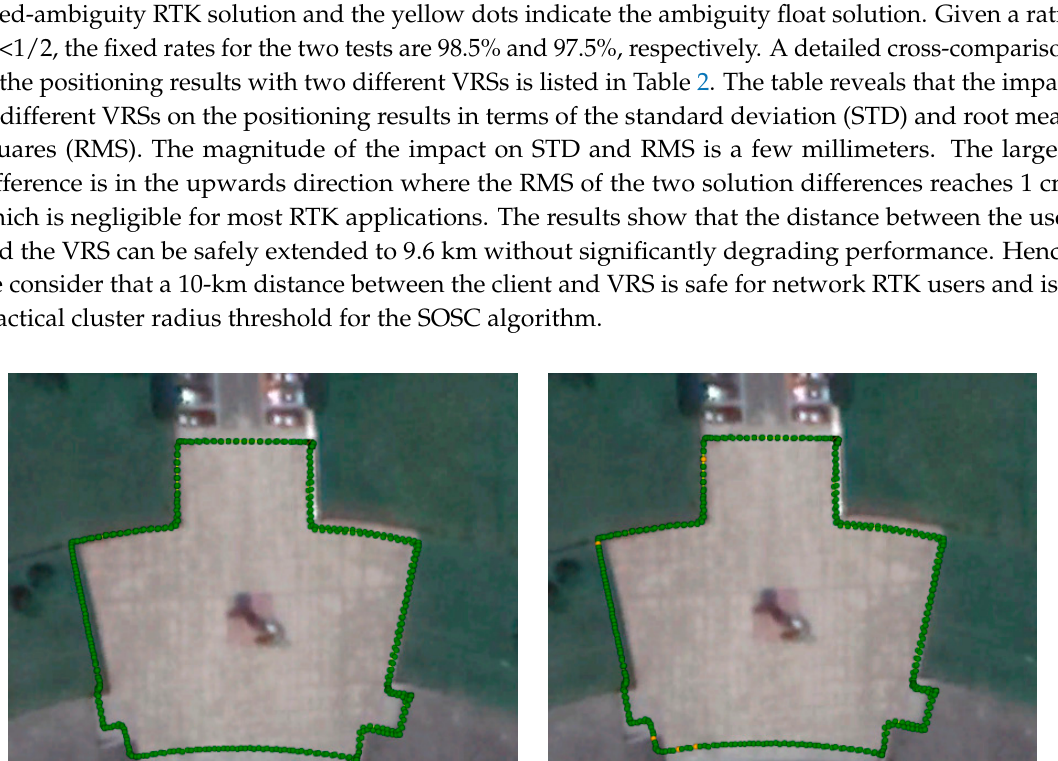
Fix Rate (Ratio <1/2)